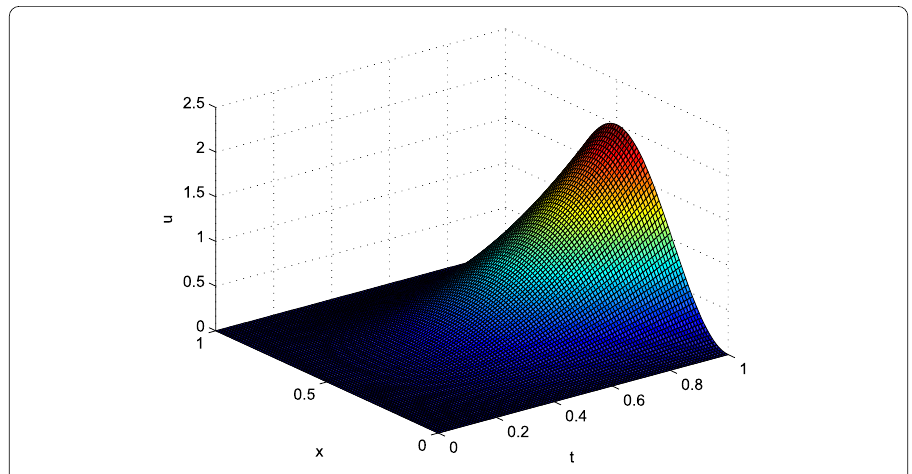
Figure 2 The numerical solution to the full-discrete scheme. The figure is the profile of the numerical solution to the cubic B-spline finite element method